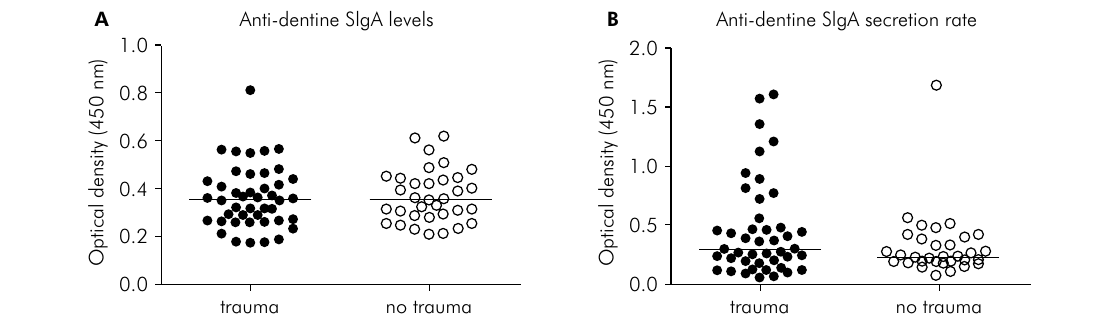
Figure 1. Analysis of (a) salivary SIgA levels (SIgA) and (b) the secretion rate of SIgA in patients who suffered dental trauma to deciduous teeth and non-trauma patients. The bar represents the median value. p > 0.05, Mann-Whitney U test.